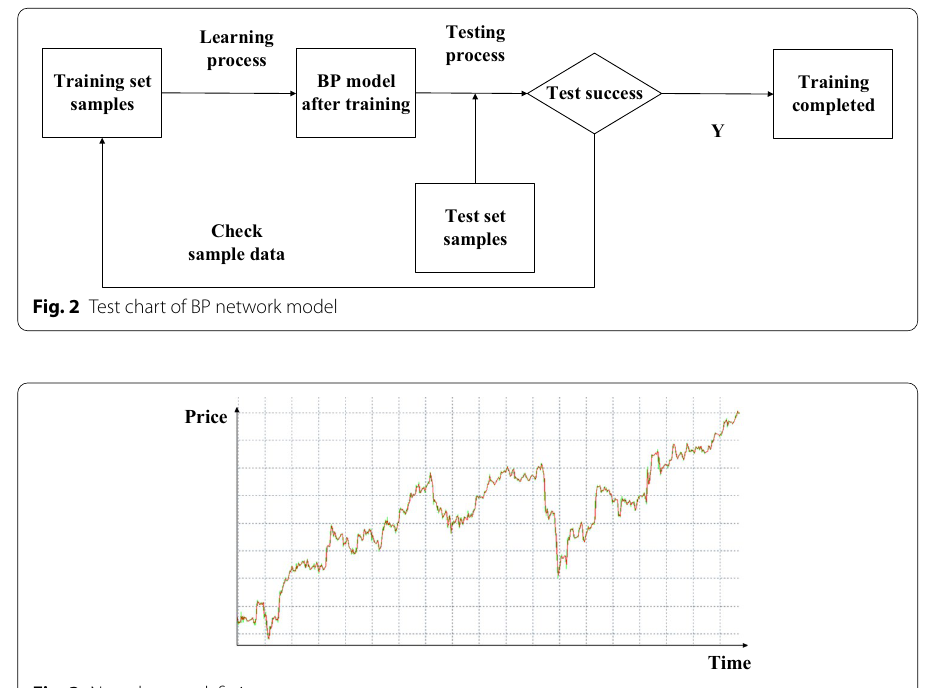
Fig. 3 Neural network fitting